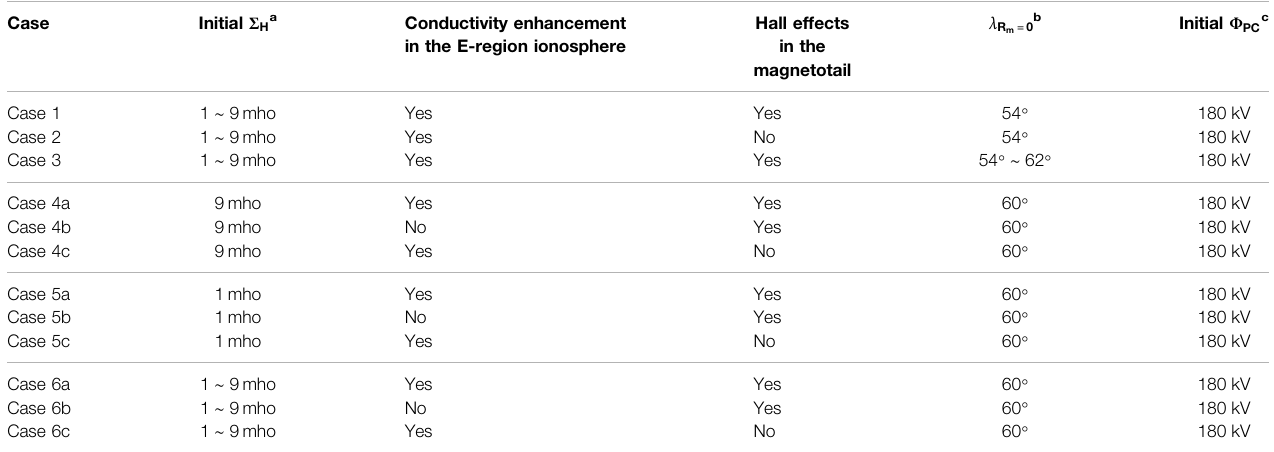
TABLE 1 | Simulation